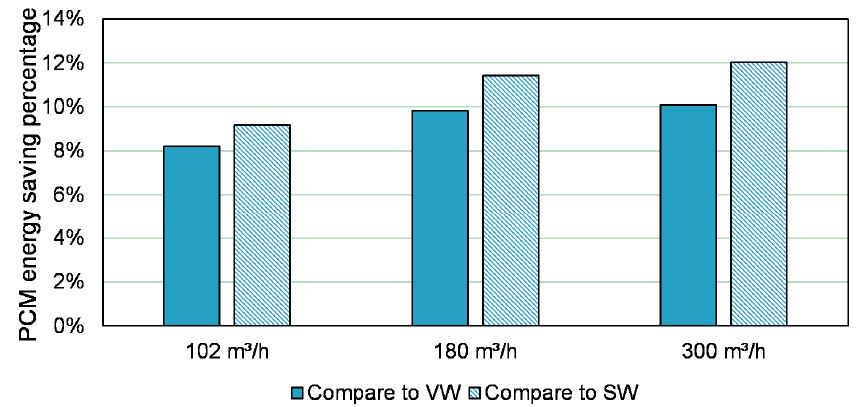
Figure 16. The PCM energy-saving potential during the summer period compared to the two reference cases.